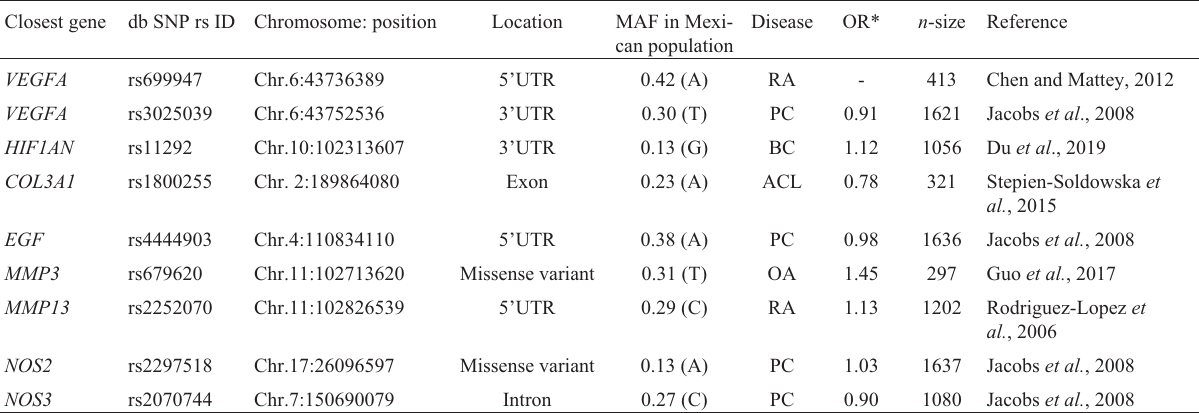
Table 1 - Single-nucleotide polymorphisms (SNPs) studied. Closest gene db SNP rs ID Chromosome: